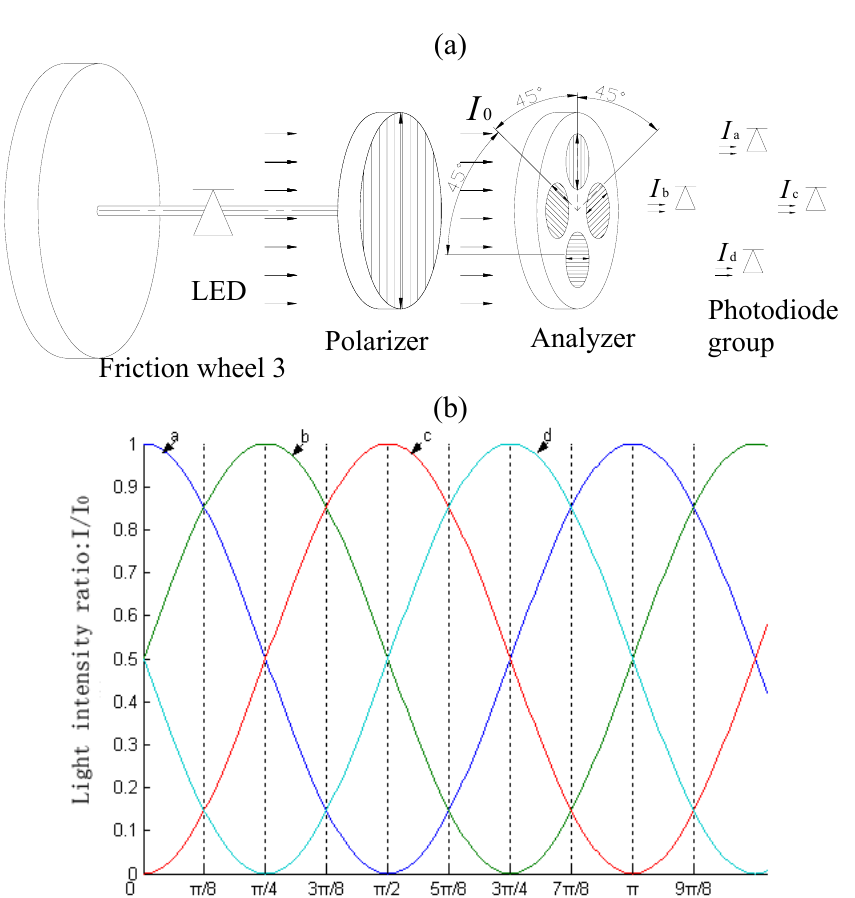
Figure 4. (a) Structure diagram of the detecting system 2. (b) Variation rule of the light intensity signals detected by the detecting system